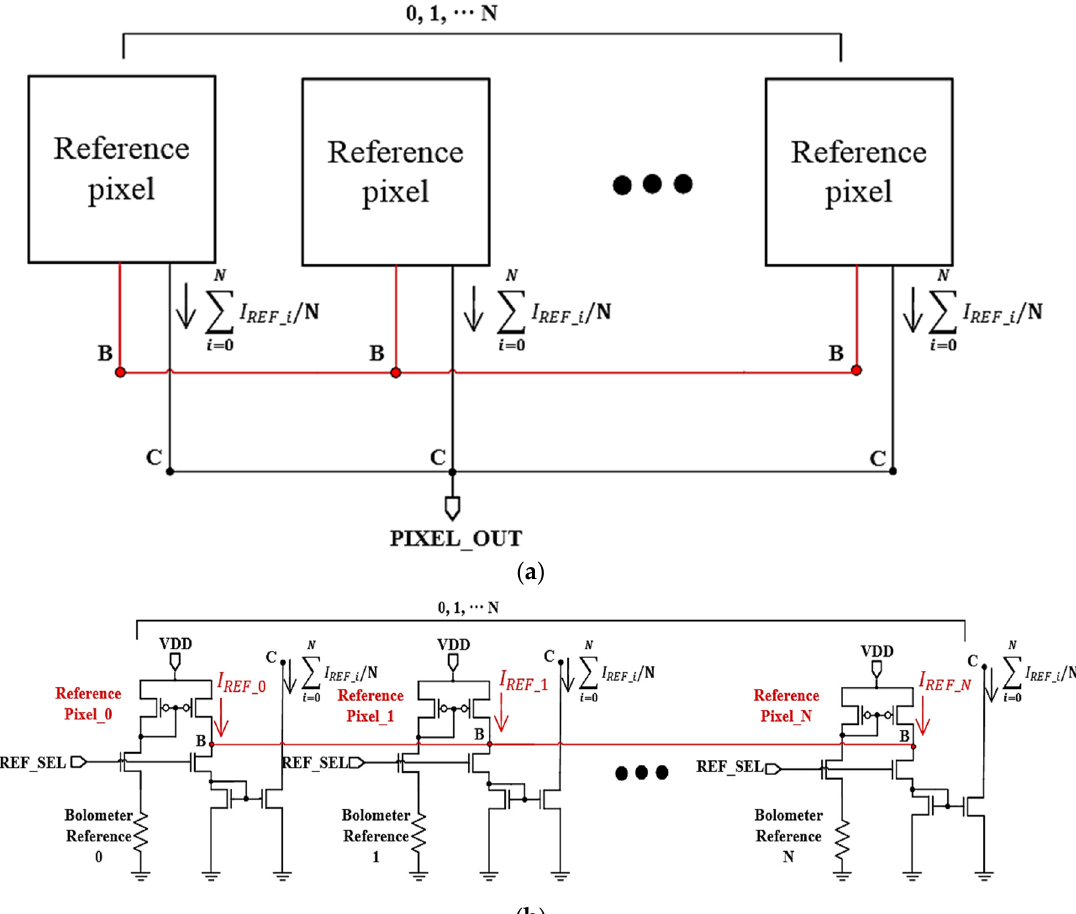
Figure 2. ( a ) Block diagram of averaging current generator using reference pixel, ( b ) schematic diagram of averaging current generator using reference pixel.